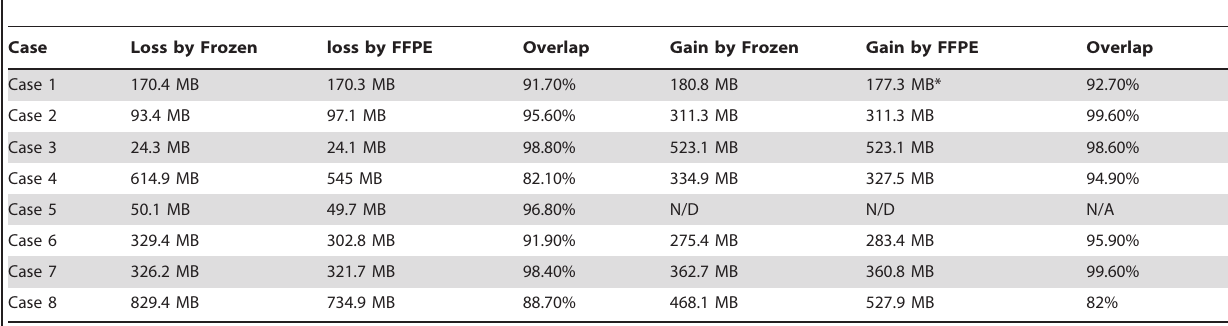
Table 2. CNV Overlaps between Frozen tissues and matched formalin-fixed paraffin-embedded tissues.